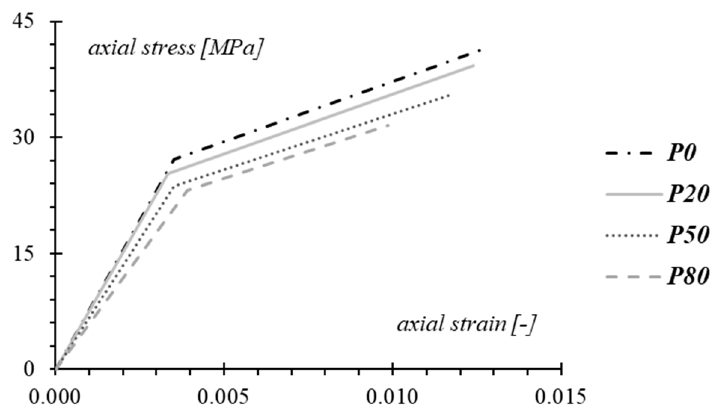
Figure 5. Pre-load effect bilinearization (each curve is the average of five specimens).